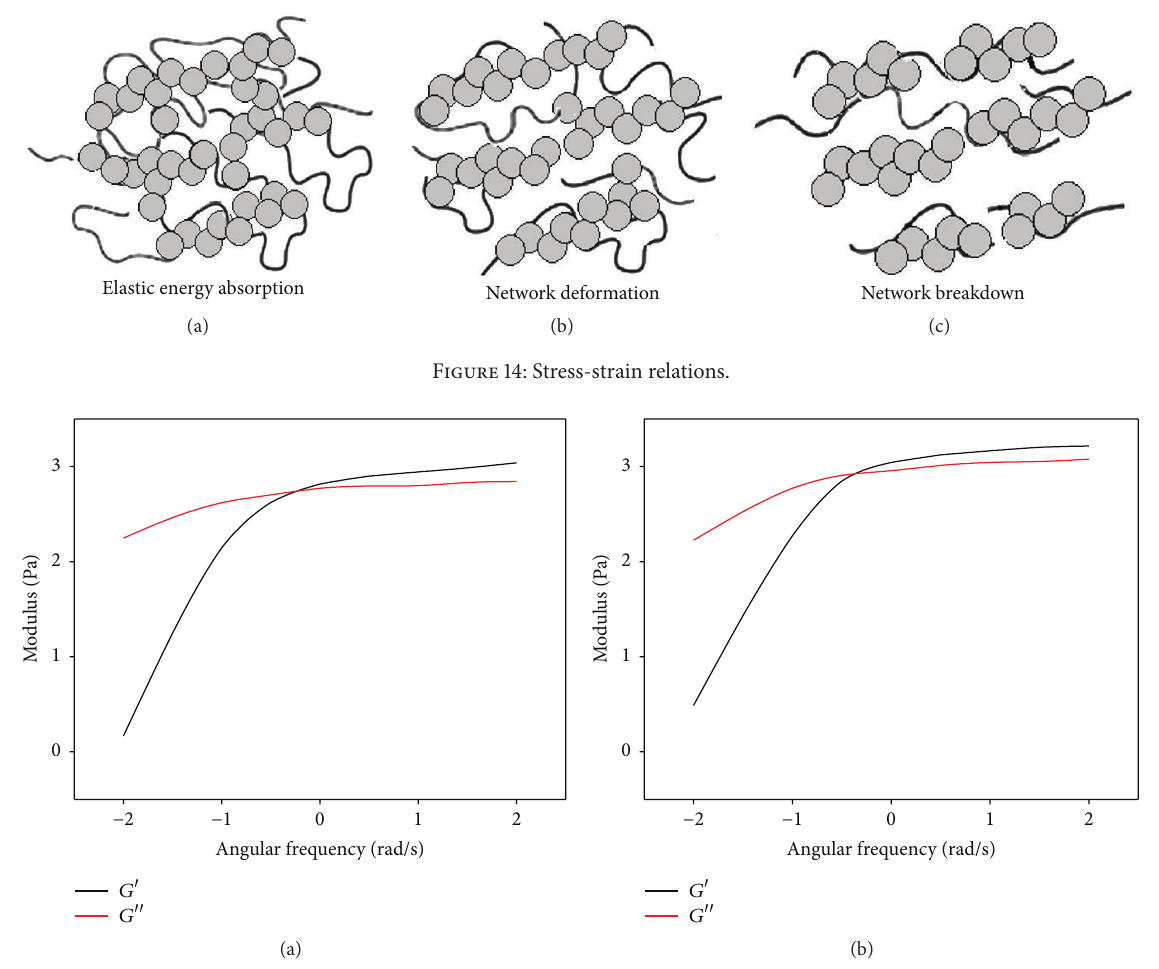
Figure 14: Stress-strain relations.